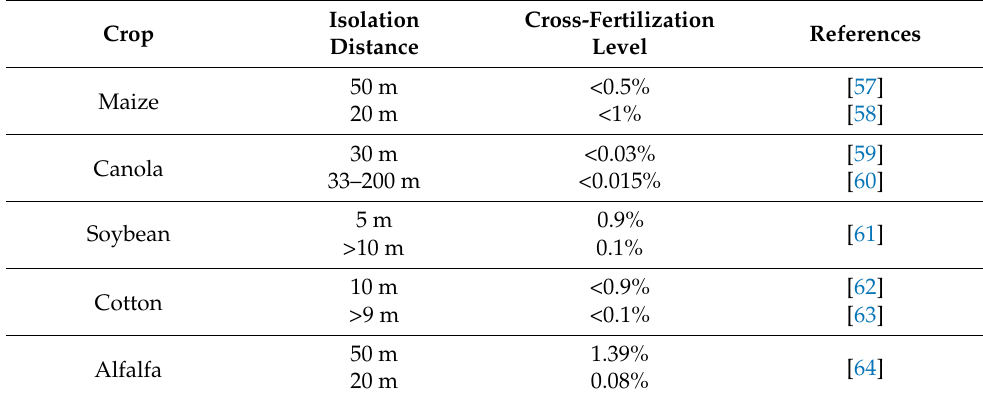
Table 1. Isolation distances required for the four major GM crops